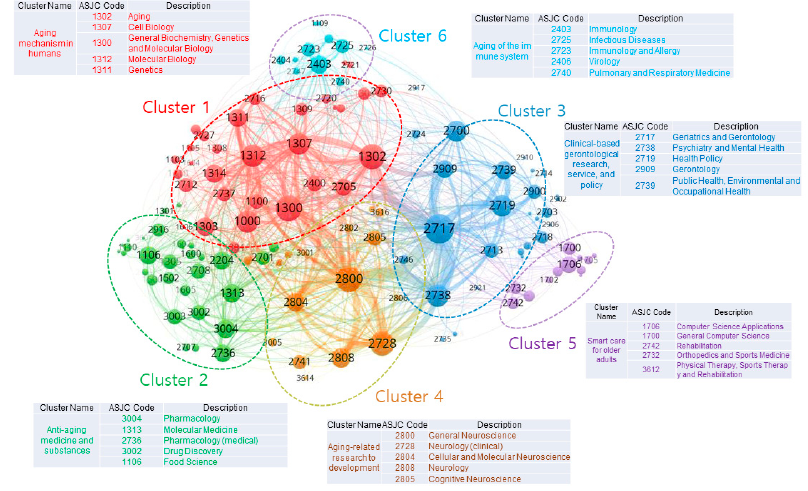
Figure 4. The interdisciplinary links between aging-related research